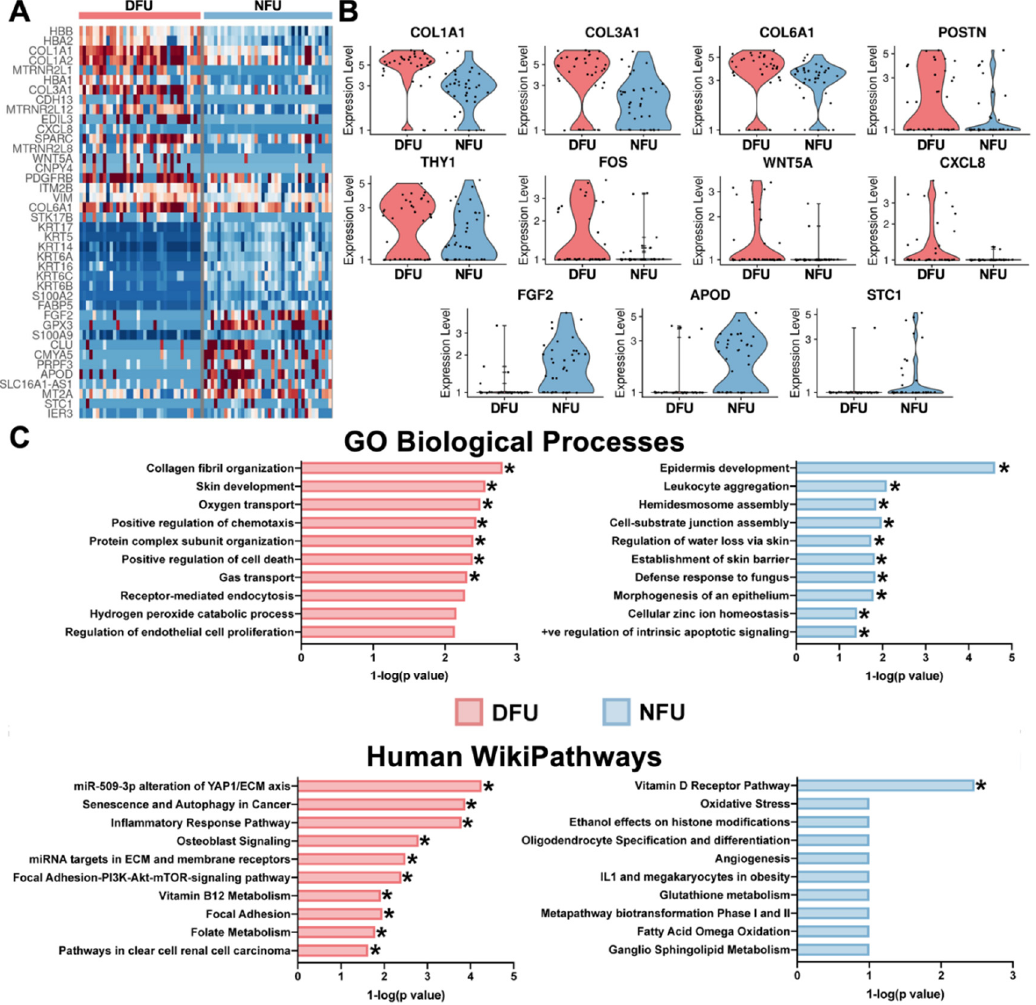
Figure 4. Diabetic wound fibroblasts exhibit increased expression of known pro-fibrotic markers. ( A ) Heatmap of differential genes between DFU and NFU in the refined fibroblasts. ( B ) Violin plots of specific differential genes. ( C ) Enrichment pathway analysis using the top twenty-five genes for each group. * ( p < 0.05).